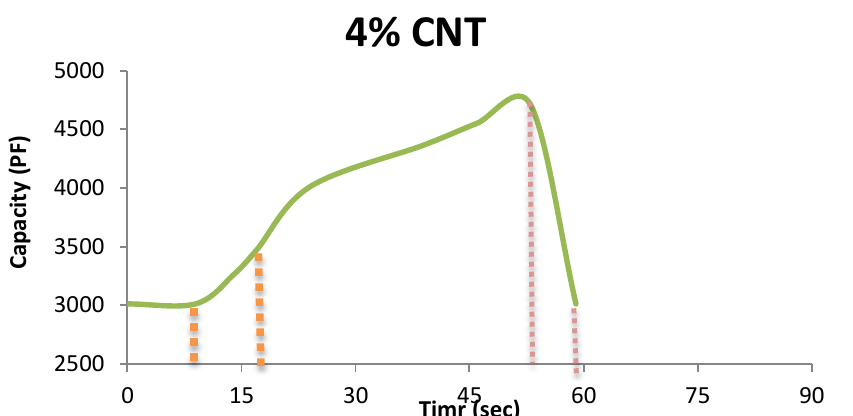
Fig.13: Response time and recovery time for humidity sensor with 4wt% MWCNT.